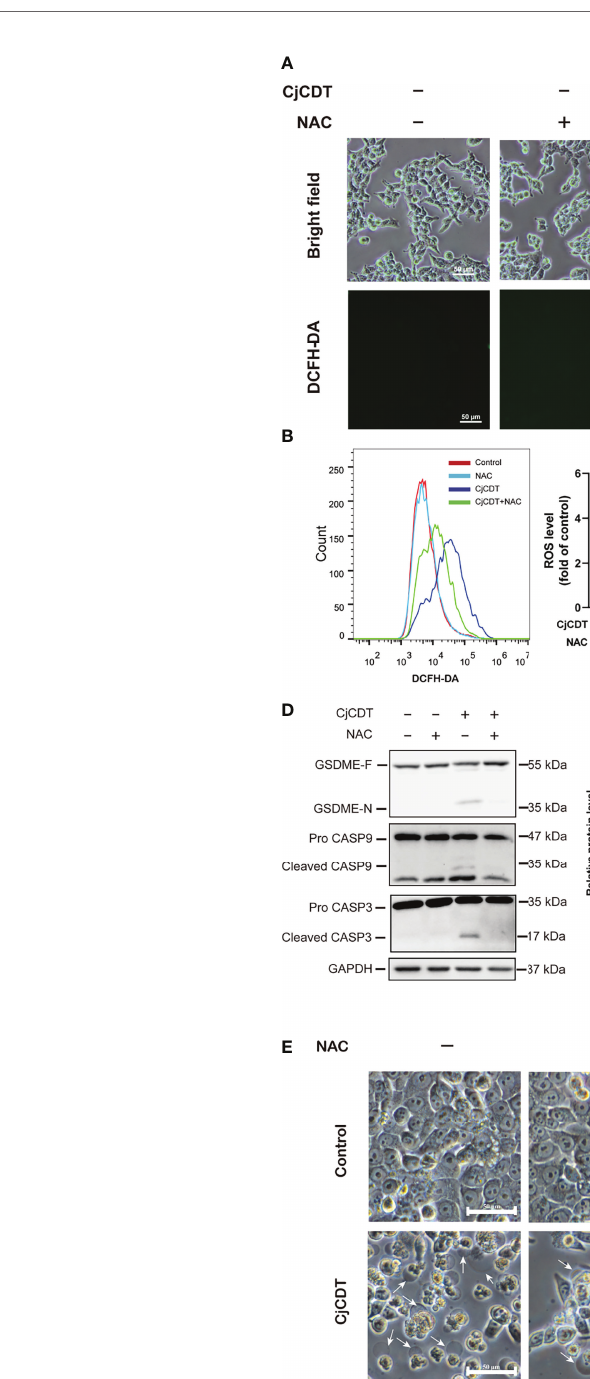
FIGURE 5 | ROS participates in CjCDT induced-pyroptosis. HCT116 cells were exposed to CjCDT (10 m g/ml) in the absence or presence of ROS scavenger NAC, and incubated for 24 h. (A) ROS levels were determined by confocal microscopy. Scale bar 50 m m. (B) ROS levels were determined by fl ow cytometry (n=3). (C) Release of LDH was measured in the culture supernatant (n=3). (D) The expression of GSDME cleaved caspase-3 and caspase-9 was detected using Western blotting in (n=3). (E) Representation morphological alterations were taken. White arrowheads indicate the pyroptotic cells characterized by large bubbles emerging from plasma membrane. Scale bar 50 m m. (F) Cell viability was detected using CCK-8 assay, * P < 0.05, ** P < 0.01, *** P < 0.001 versus control using one-way